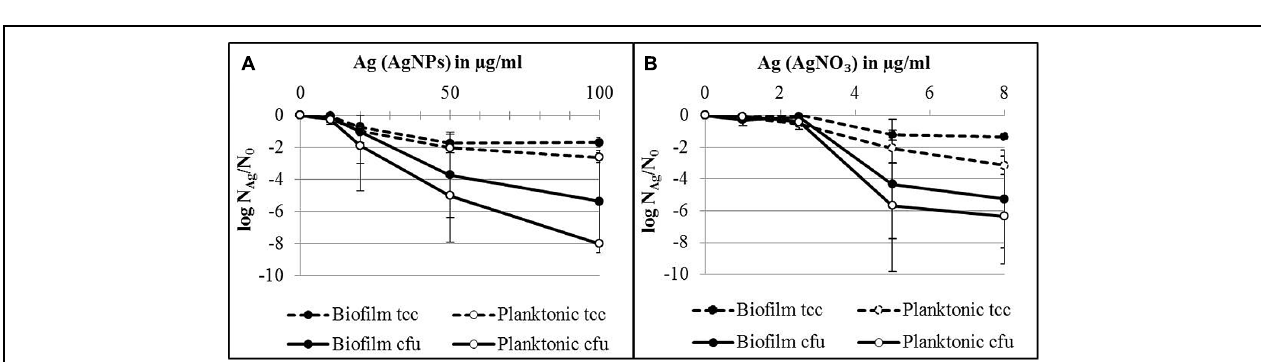
FIGURE 3 | Total cell counts (tcc) and colony counts (cfu) of planktonic cells and biofilms of P. aeruginosa AdS in the presence of AgNPs (A) and AgNO 3 (B) in LB broth after 24 h at 36 ◦ C. N 0 (planktonic cells): 2 × 10 9 cells per well (tcc) and 1 × 10 8 cfu per well, N 0 (biofilm cells): 7 × 10 7 cells per well (tcc) and 2 × 10 7 cells/well. Statistical analysis: ANOVA followed by Dunett’s test. n = 3.